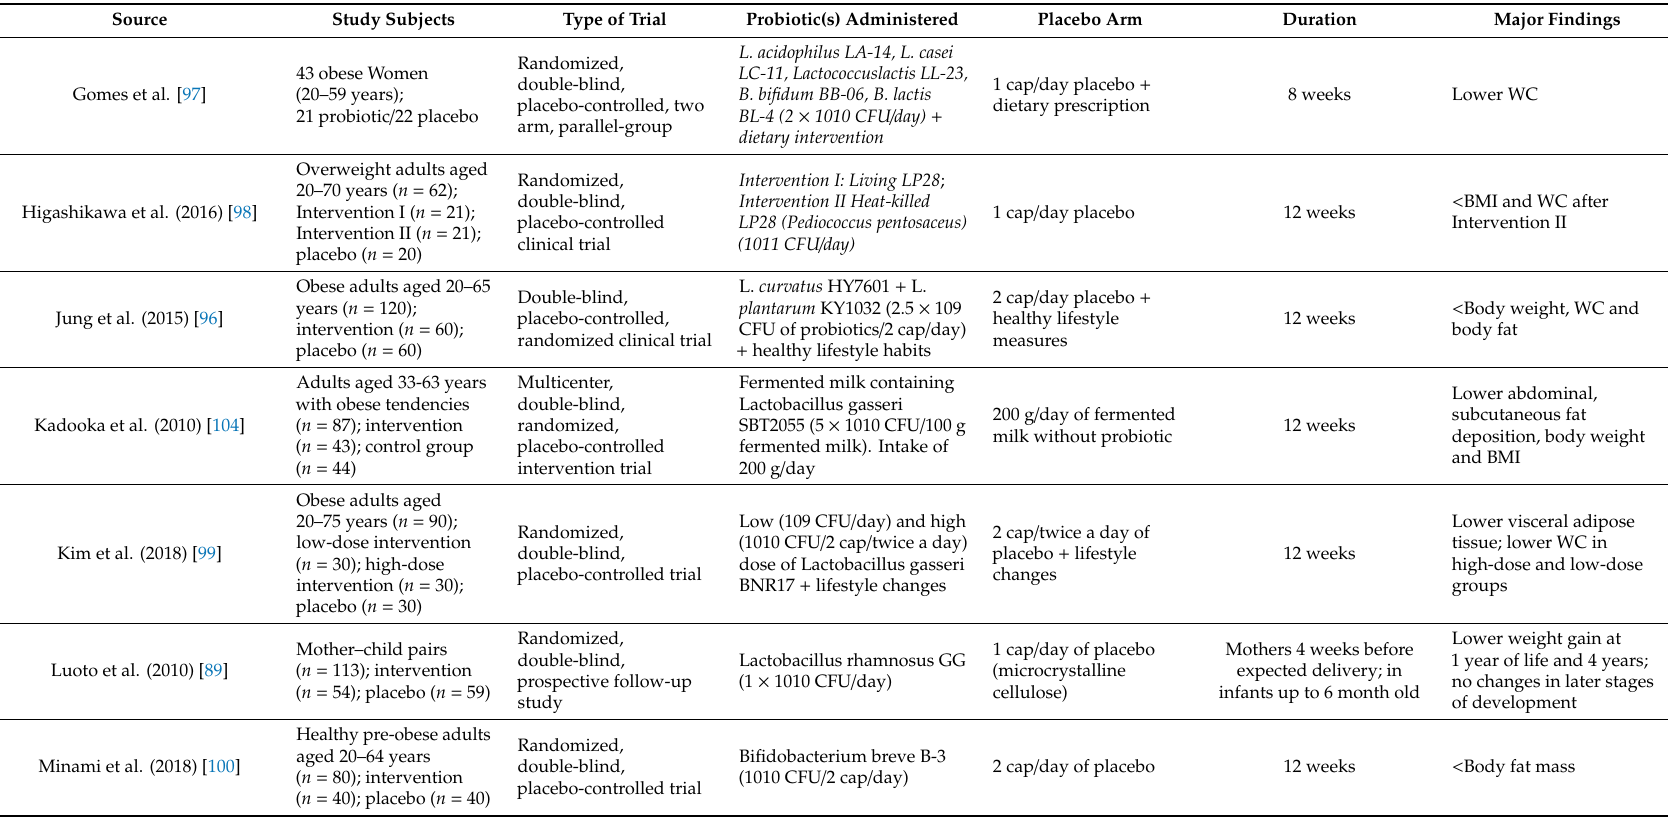
Table 3. Probiotics and obesity: gut microbiota modulation in human